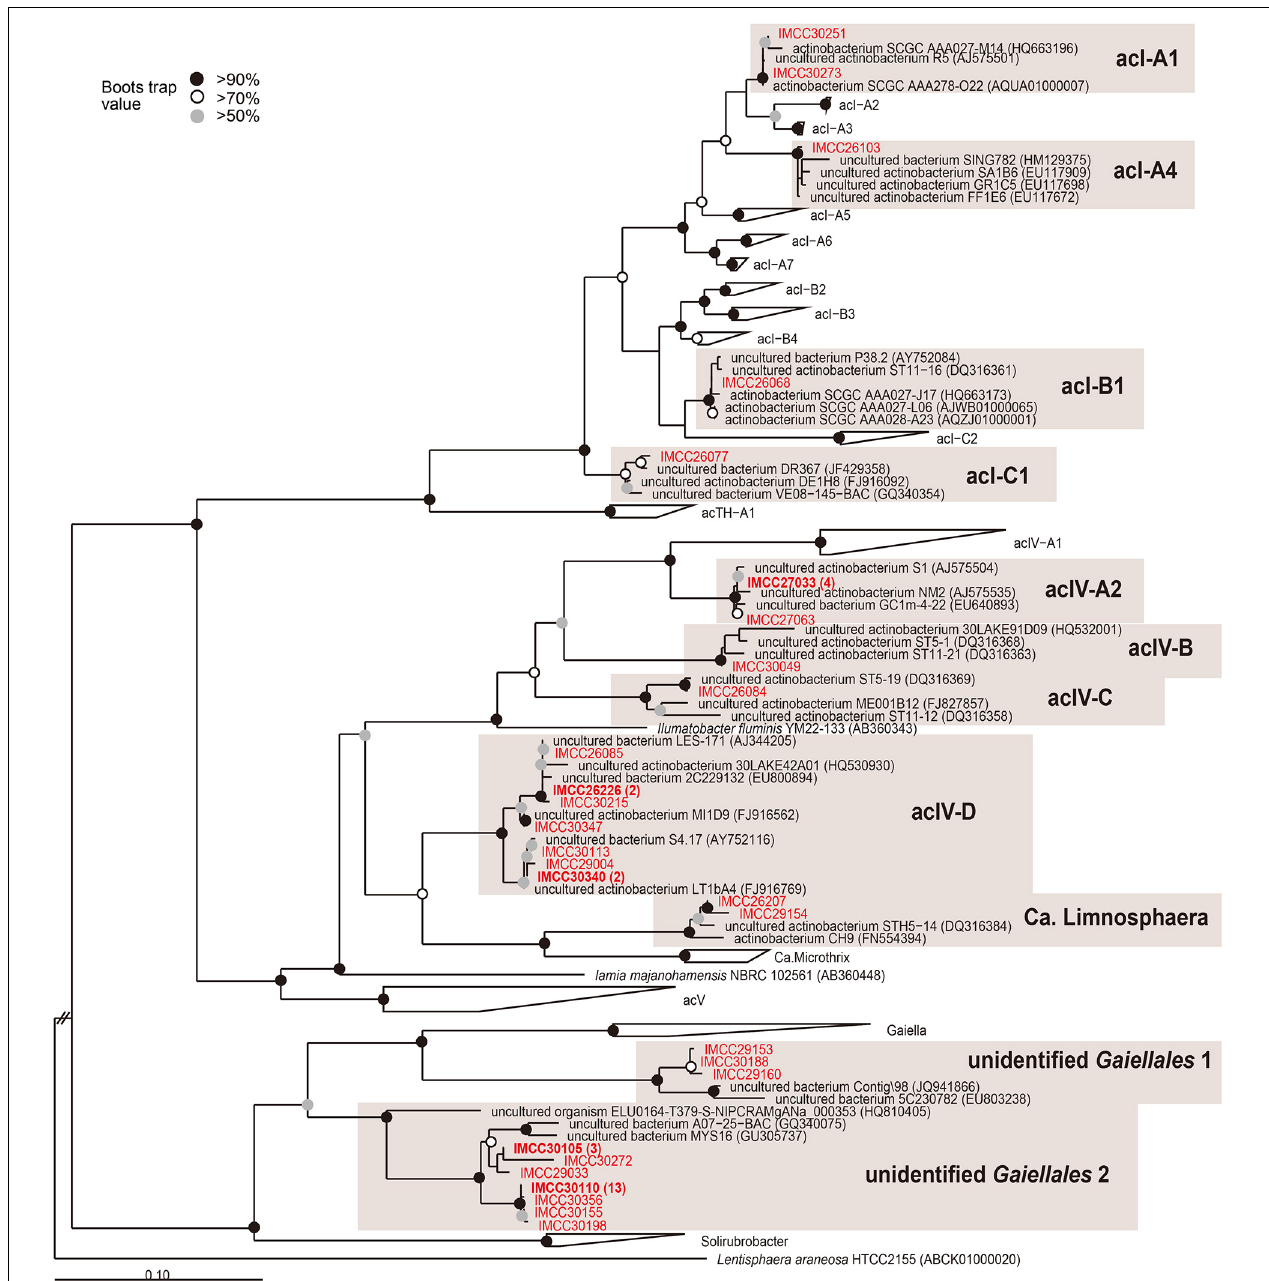
FIGURE 3 | Maximum-likelihood phylogenetic tree based on 16S rRNA gene sequences showing the positions of the HTC isolates within the phylum Actinobacteria . The HTC isolates are prefixed with the “IMCC” abbreviation (Inha Microbe Culture Collection) and marked in red. HTC isolates sharing identical 16S rRNA gene sequences are indicated by one representative strain and the numbers of the other isolates sharing the same sequences are indicated in parentheses. The “unidentified Gaiellales 1” and “unidentified Gaiellales 2” lineages were named in this study. Bootstrap supporting values are shown at the nodes as solid circles ( > 90%), empty circles ( > 70%), and gray circles ( > 50%).